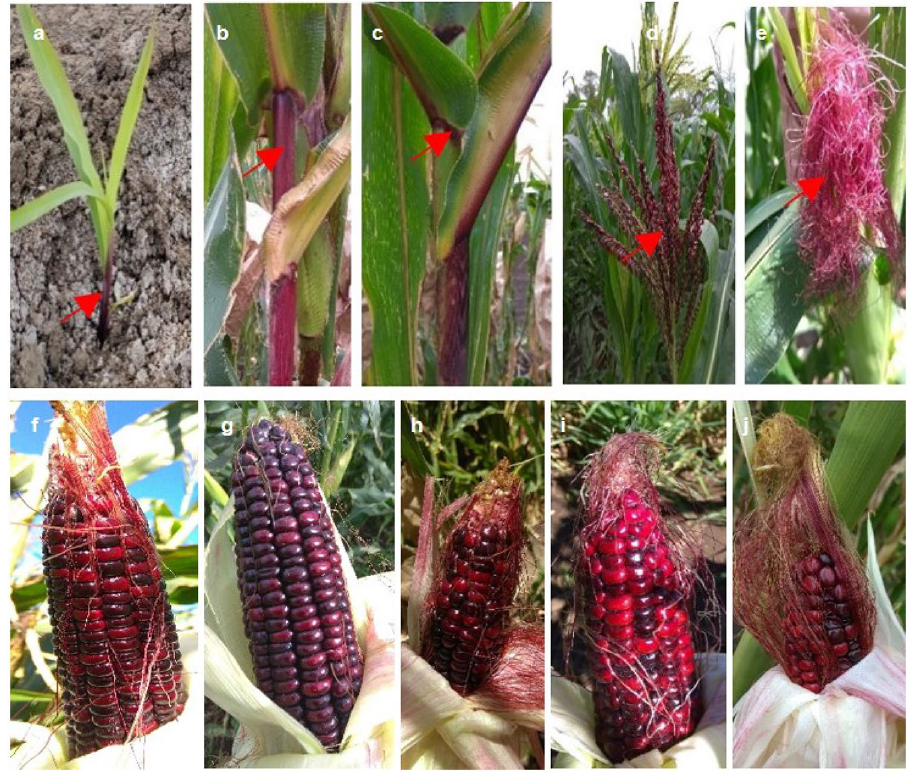
Figure 2. Purple pigmentation in different tissues of F3 plants at different stages of plant development: ( a ) sheath-leaf, ( b ) stem, ( c ) auricle, ( d ) anthers, and ( e ) silks. Developed purple F3 cobs: ‘Tim1’ to ‘Tim5’ ( f–j ) at milk/eating stage, prior to exhibiting the mature shrunken